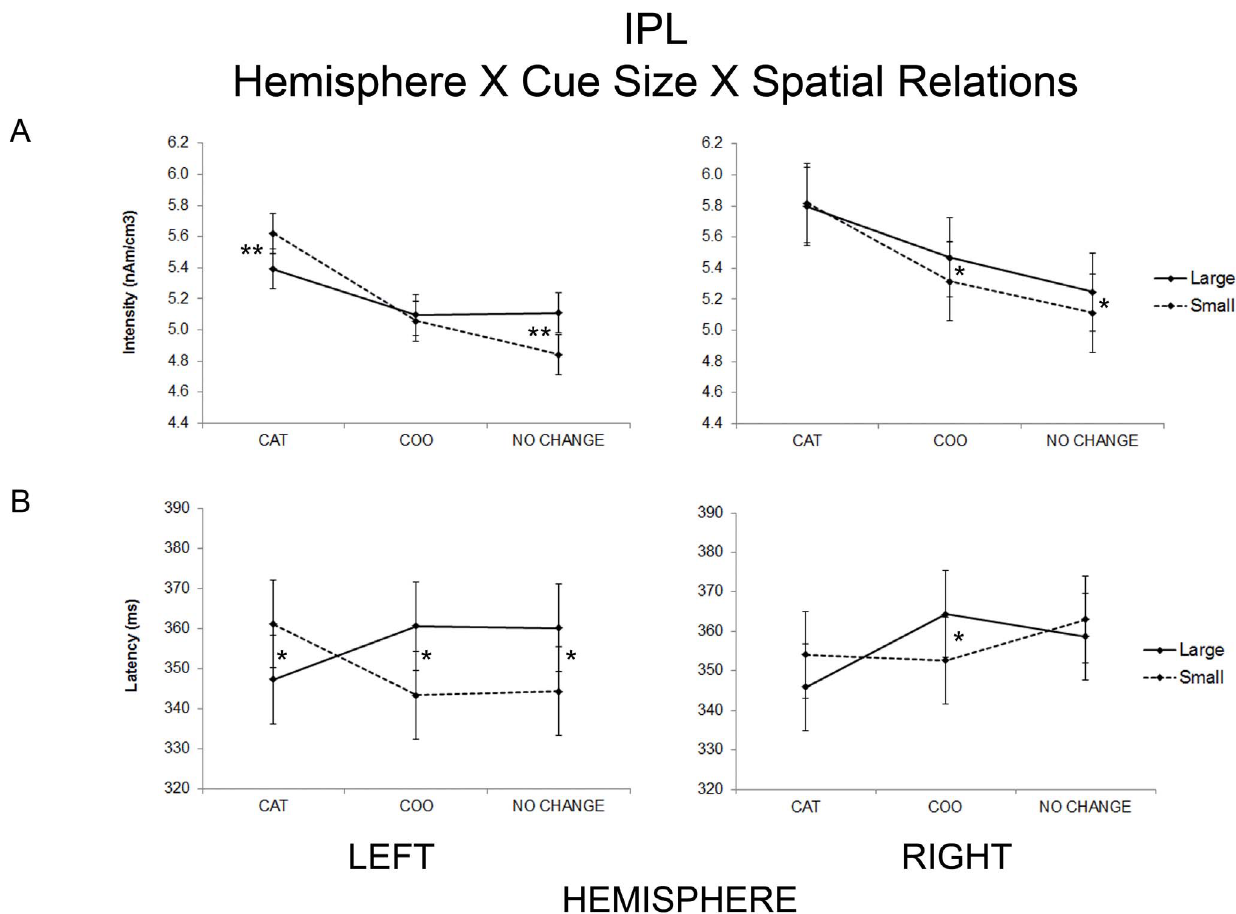
Figure 4. Significant statistical results. Relevant statistical results for the strength (A) and peak latency (B) obtained for the inferior parietal lobe. In the left hemisphere categorical spatial relations yielded greater activity and longer latencies when the attention window was small; in the right hemisphere, coordinate spatial relations yielded greater activity and longer latencies when the attention window was large. Error bars are computed according to the formula for within-subject designs by Loftus and Masson [72] * p , 005; **p , 0001, significant post hoc comparisons.